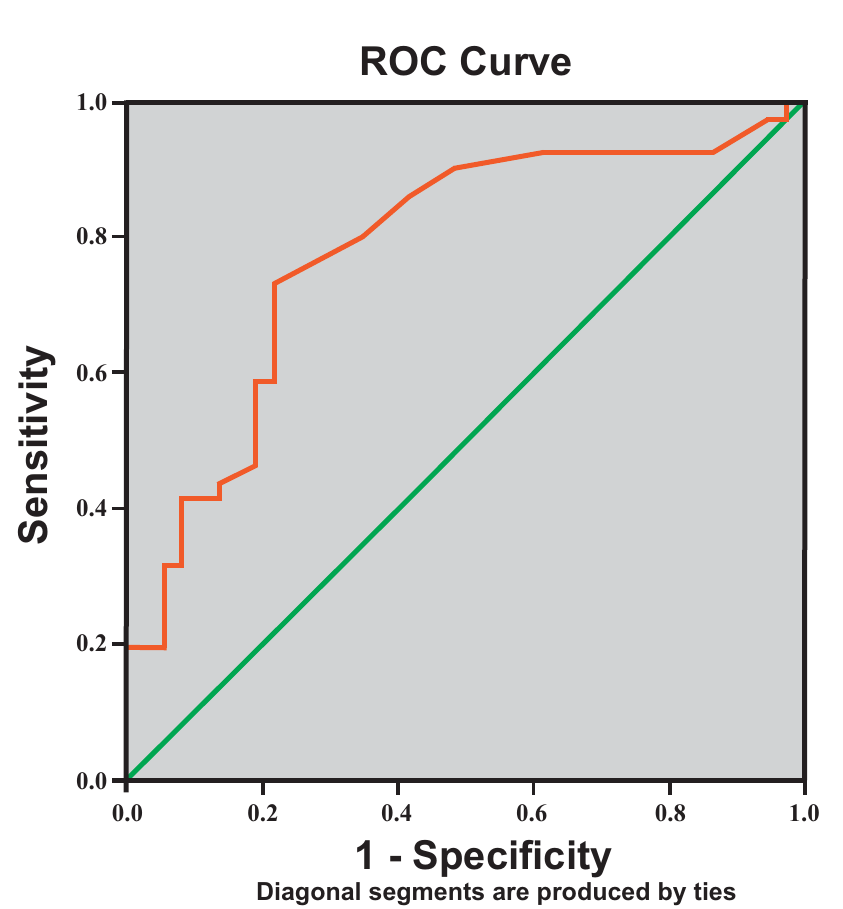
Fig 5. Receiver-operating-characteristic (ROC) curve. Receiver-operating-characteristic (ROC) curve illustrating the relationship between sensitivity and complement of specificity (1-specificity) for the modern standard Arabic version of Lower Extremity Functional